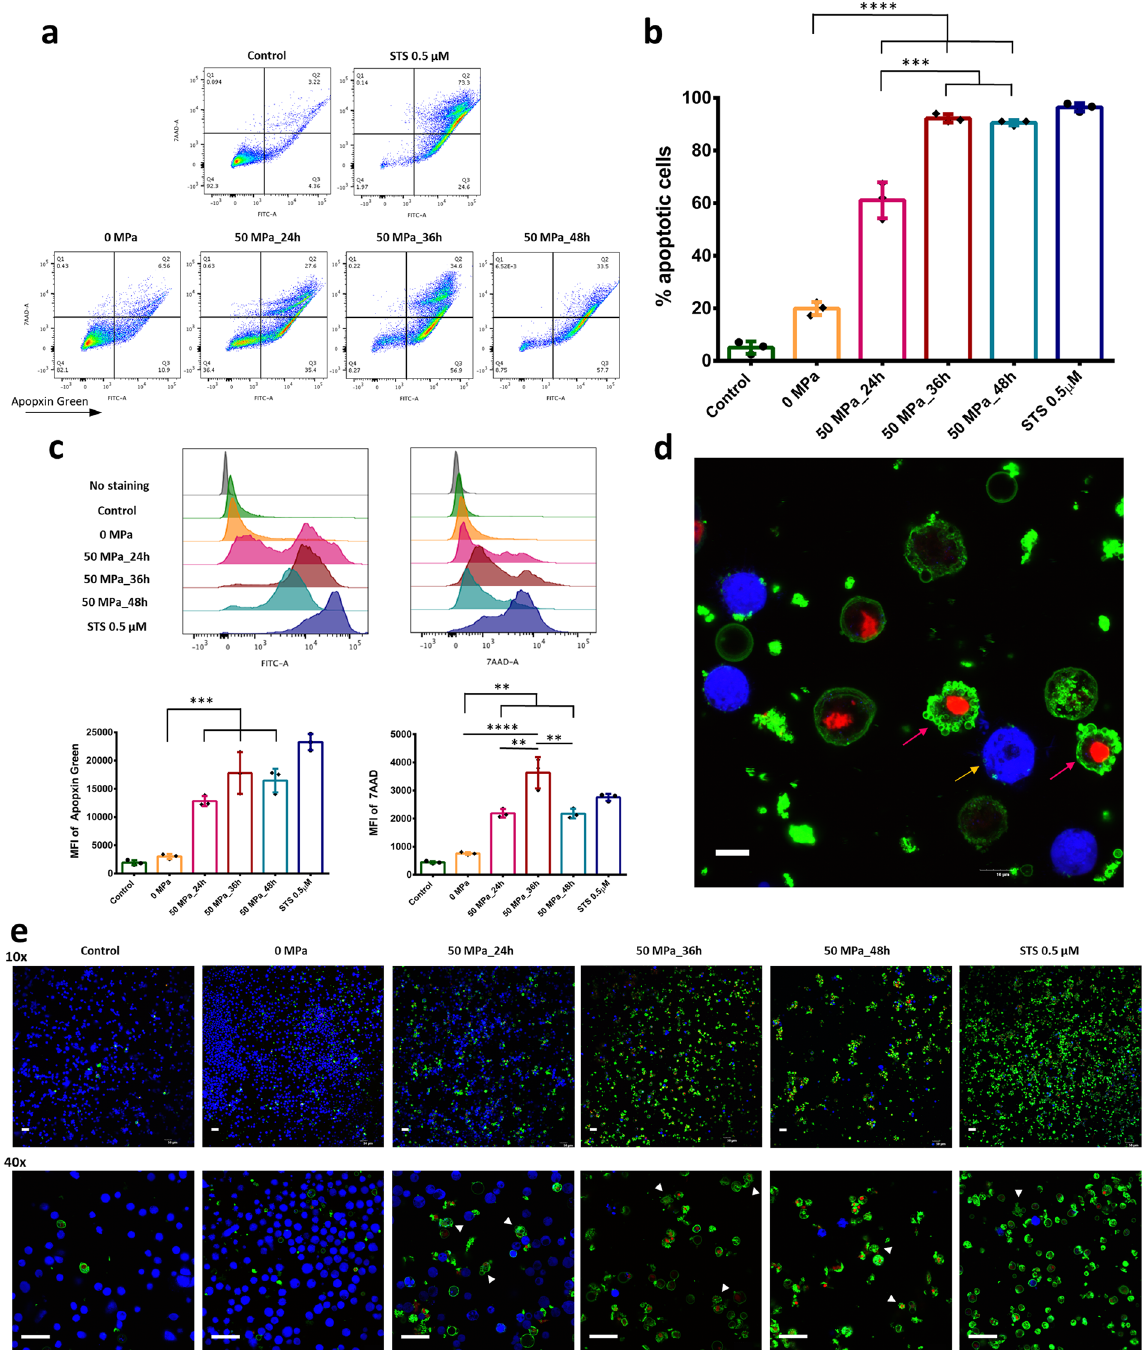
Figure 2 . Detection of apoptotic cells by PS externalization and membrane permeability. ( a ) Fibroblast cells were treated with 50 MPa HHP for different durations or with STS. Each cell is represented by a dot plot in the flow cytometer diagram formed by the combination of Apopxin Green-FITC and 7-AAD immunofluorescence. ( b ) The comparison of total apoptotic cells among groups. The control and STS treatment groups are not compared (n = 3). ( c ) Representative histograms of different fluorescence expression values and the comparison of the mean fluorescence intensity (MFI) of Apopxin Green (FITC) and 7-AAD (n = 3). ( d ) Immunofluorescence image of apoptosis/necrosis staining of cells treated by HHP for 36 h. Magnification 100×, scale bar: 10 μm. ( e ) Immunofluorescence images of apoptosis/necrosis staining show the difference in the density of viable cells (blue color) and apoptotic cells (green/red color) or dead cells (red color) in small magnification (10×, scale bar 50 μm) among groups. At higher magnifications (40×, scale bar 20 μm), the morphological characteristics of other stages of apoptotic cells in each group can be observed, particularly the release of apoptotic bodies (white arrowhead). Data are representative of at least three independent